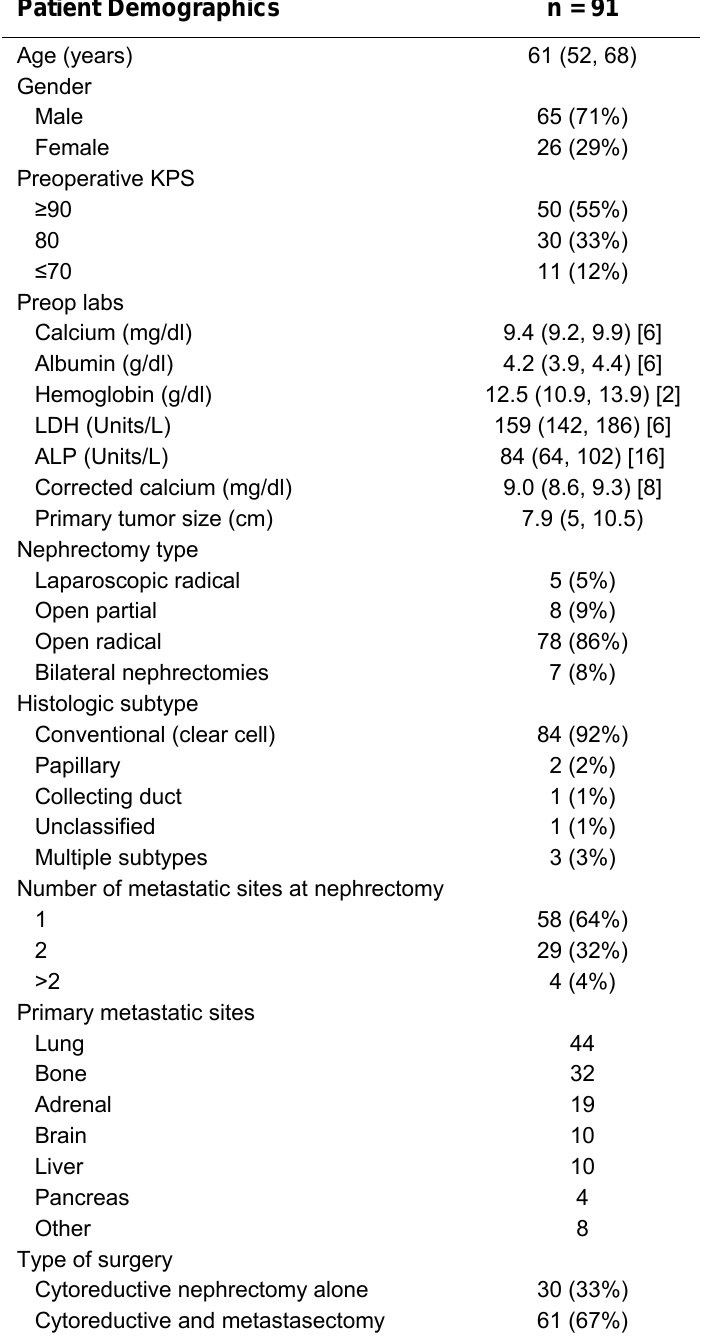
Patient and Tumor Characteristics of the Study